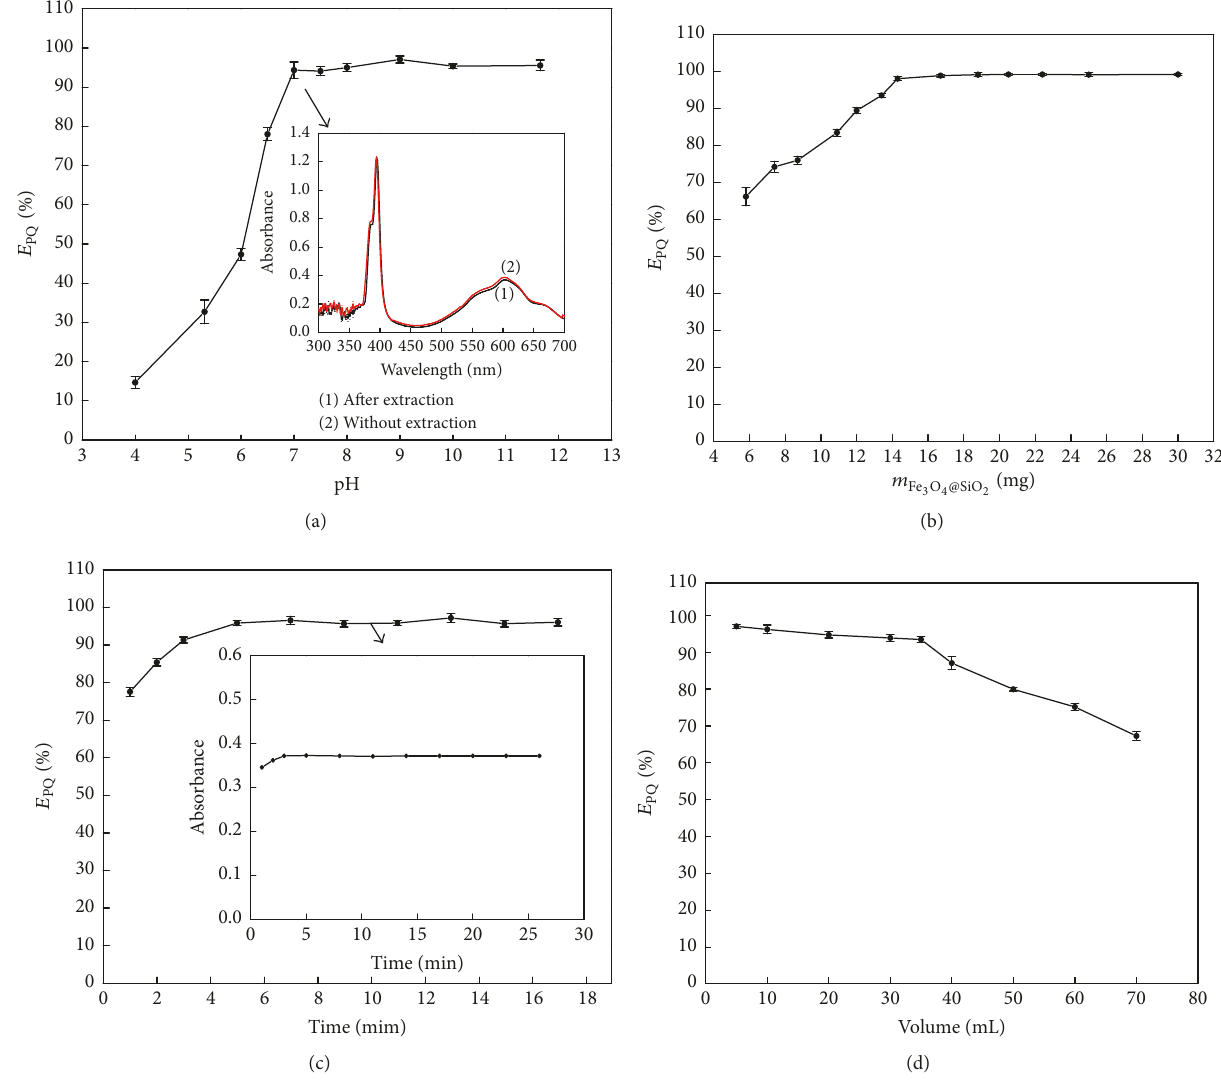
Figure 3: Factors affecting the extraction efficiency. The extraction efficiency ( 𝐸 PQ %) was determined as a function of pH (a), the amount of Fe 3 O 4 @SiO 2 (b), the extraction time (c), and the sample volume